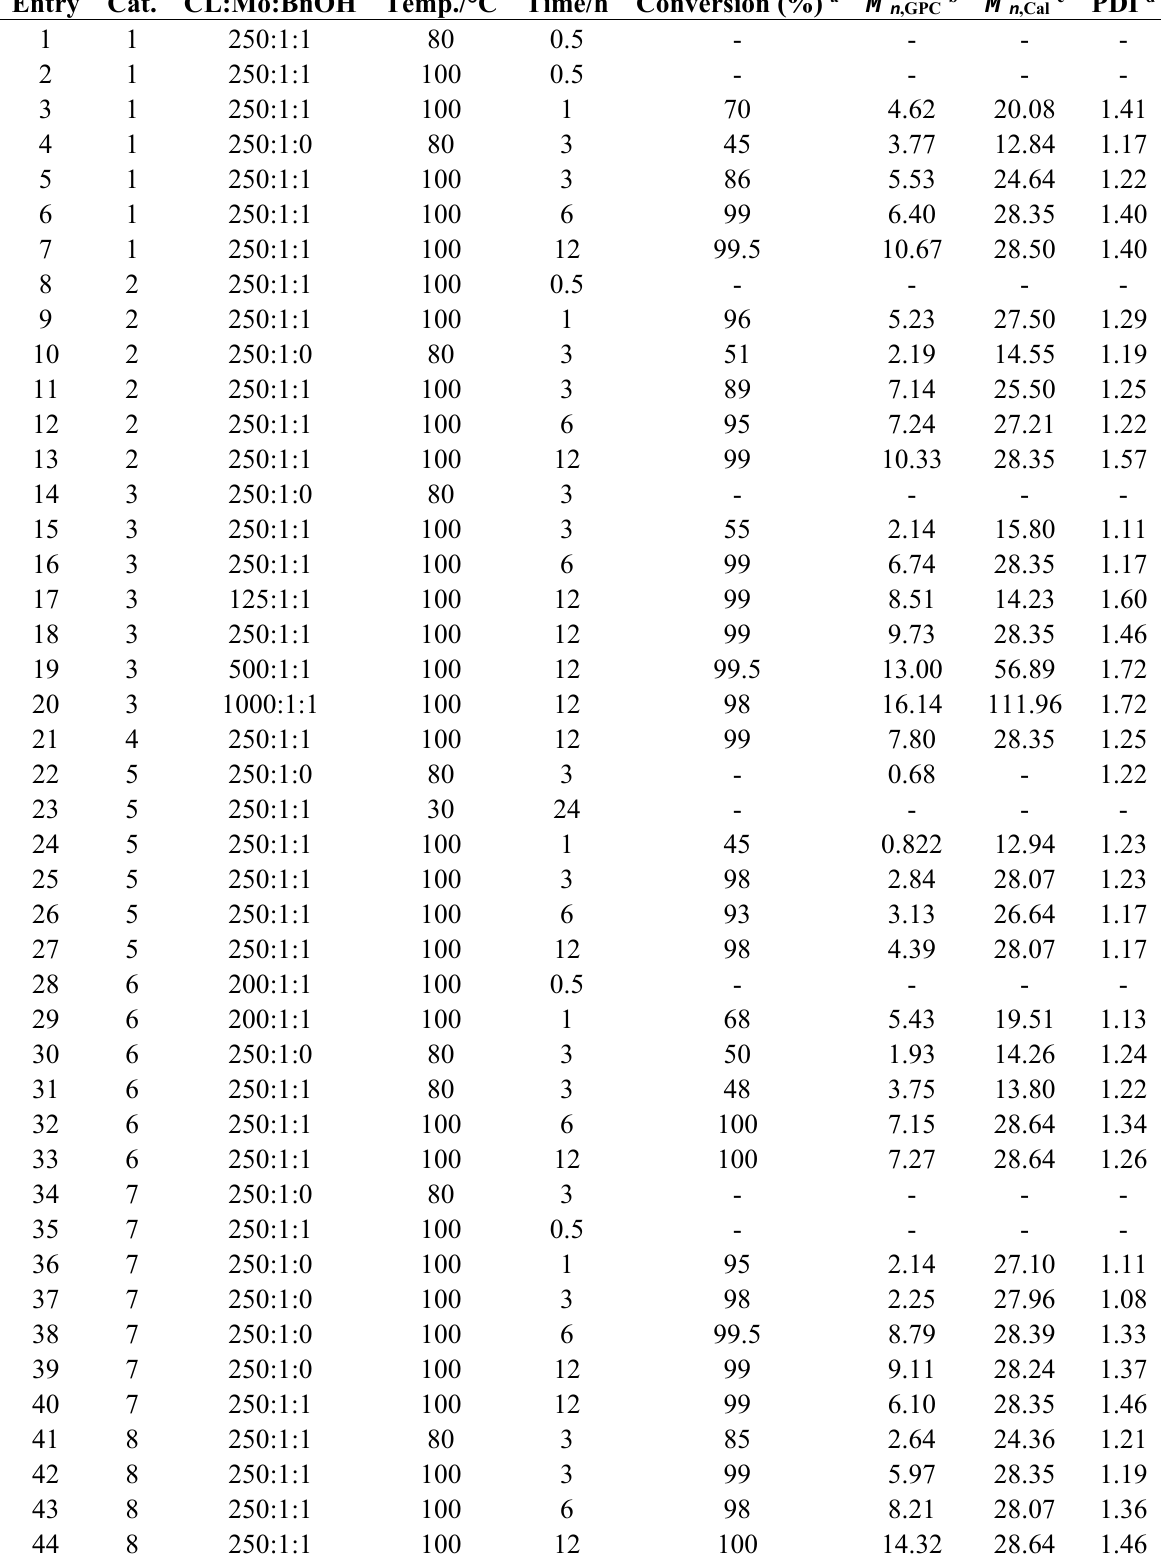
Table 2. Ring opening polymerization of ɛ -CL using complexes 1 – 8